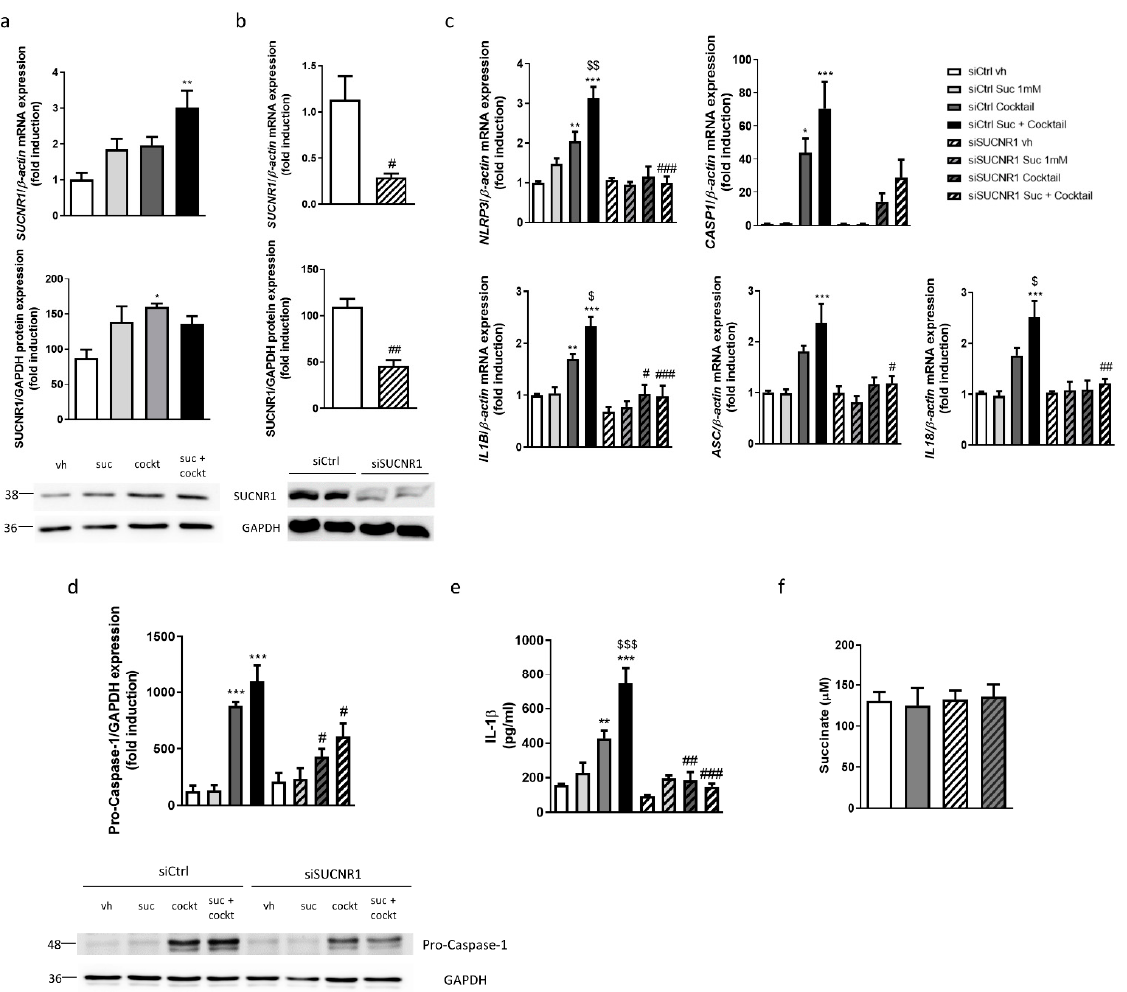
Figure 1. SUCNR1 mediates inflammasome priming in intestinal epithelial cells. ( a ) HT29 cells treated with succinate 1 mM and/or an inflammatory cocktail. Graphs show mRNA ( n = 7) and pro- tein ( n = 3) expression of SUCNR1. Image of a representative Western Blot of one independent ex- periment. Bars in graphs represent mean ± SEM; * p < 0.05 and ** p < 0.01 vs. vehicle cells. ( b – e ) HT29 cells transiently transfected with a specific siRNA against SUCNR1 or ctrl; ( b ) Graphs show mRNA and protein expression of SUCNR1 ( n = 5). ( c ) Graphs show mRNA expression of NLRP3, CASP1 , IL1B , ASC and IL18 ( n = 5). ( d ) Graph shows protein expression of pro-Caspase-1 ( n = 4). Image of a representative Western Blot of one independent experiment. ( e ) Graph shows secreted protein levels of IL-1 β detected in the supernatant of HT29 cells ( n = 3). ( f ) Graph shows succinate levels in super- natant of HT29 cells ( n = 6). In all cases, bars in graphs represent mean ± SEM. * p < 0.05, ** p < 0.01 and *** p < 0.001 vs. siCtrl vehicle cells. # p < 0.05, ## p < 0.01 and ### p < 0.001 vs. the respective siCtrl cells. $ p < 0.05, $$ p < 0.01, $$$ p < 0.001 vs. siCtrl cocktail treated cells. 3.2. SUCNR1 Mediates Basal and LPS-Stimulated Inflammatory Pathways in Intestinal Epithelial Cells The effect of LPS on SUCNR1 expression was analyzed in HT29 cells and results showed a significant increase in both gene and protein expression of this receptor after treatment with LPS during 24 h (Figure 2a). As shown in Figure 2b, LPS increased the ratio pNF к B/NF к B, while it failed to significantly modify the ratio pERK-1/2/ERK-1/2